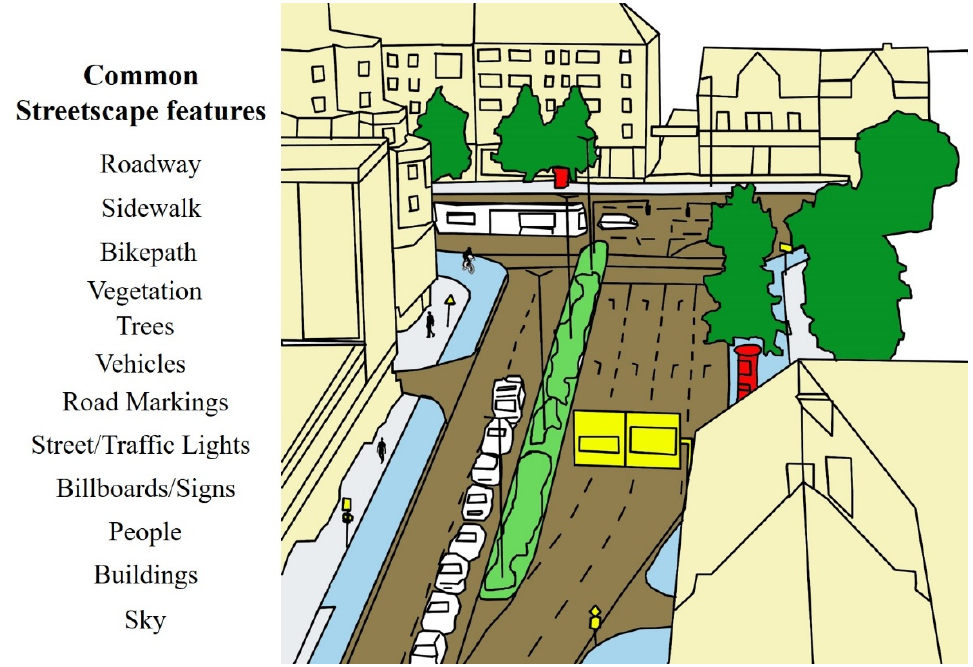
Figure 1. Illustration showing common streetscape features in cities.